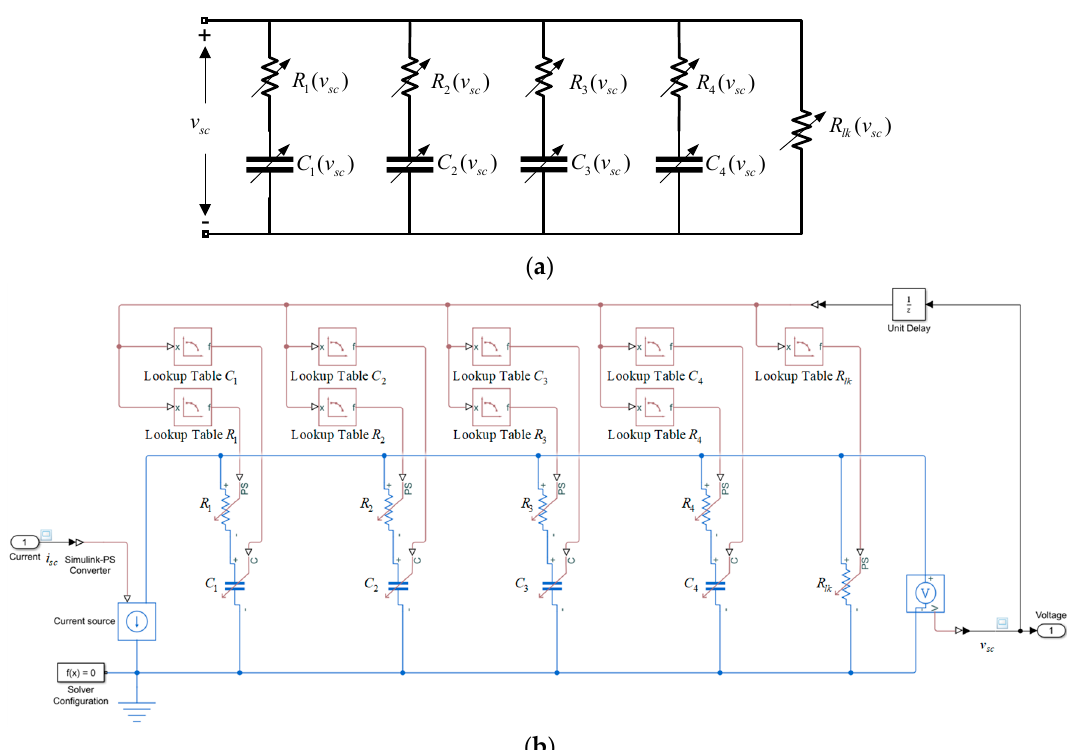
Figure 4. Series model: ( a ) Electric circuit; ( b ) Simscape implementation.